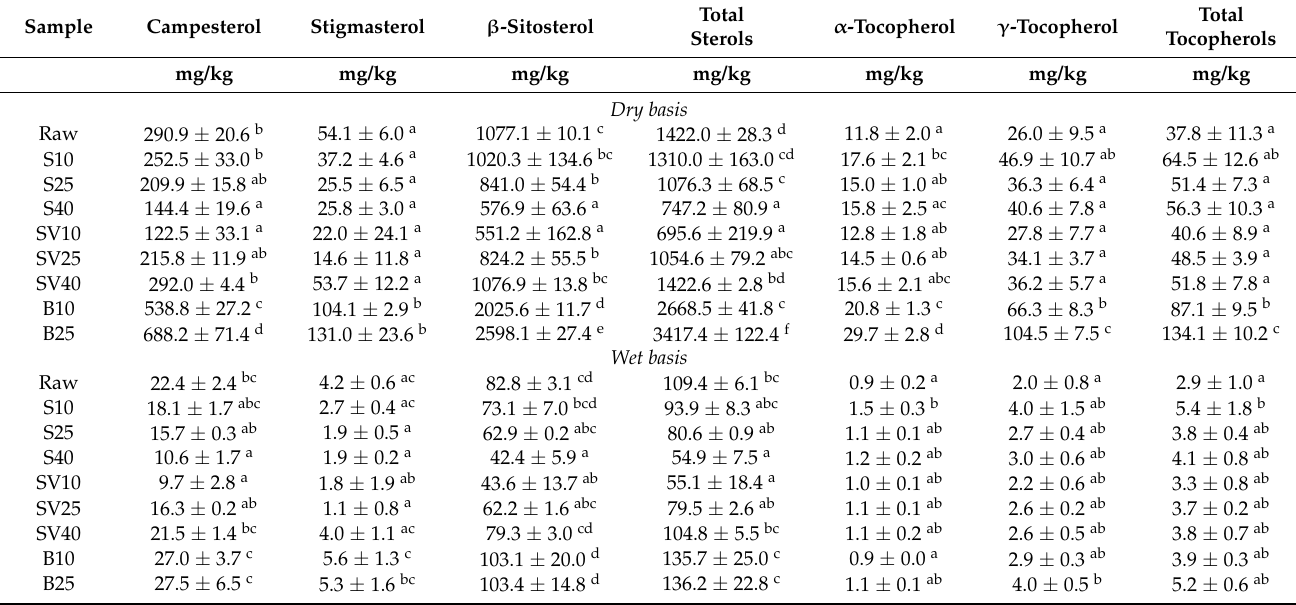
S10, S25, and S40 indicate 10, 25, and 40 min of exposure to steaming in the saturated oven; SV10, SV25, and SV40 indicate 10, 25, and 40 min of exposure to sous-vide in the saturated oven; B10 and B25 indicate 10 and 25 min of exposure to boiling in the hot water. Different letters within columns indicate significant differences (Tukey’s test, p <